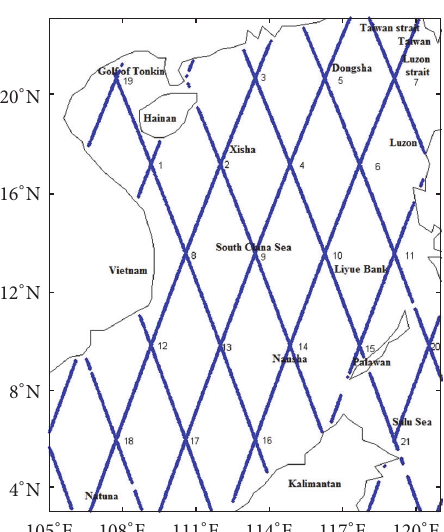
Figure 2: Topex/Poseidon crossover points in the